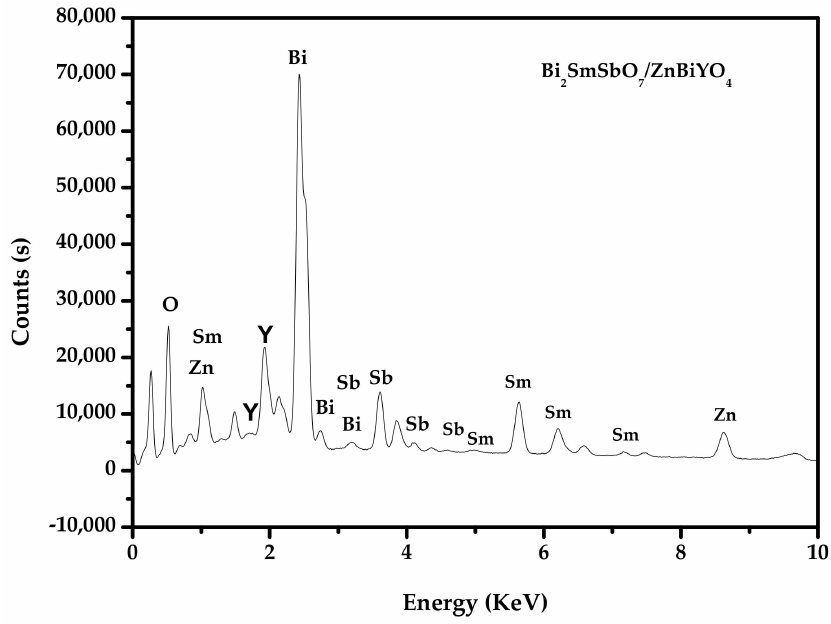
Figure 11. EDS spectrum of Bi 2 SmSbO 7 /ZnBiYO 4 heterojunction